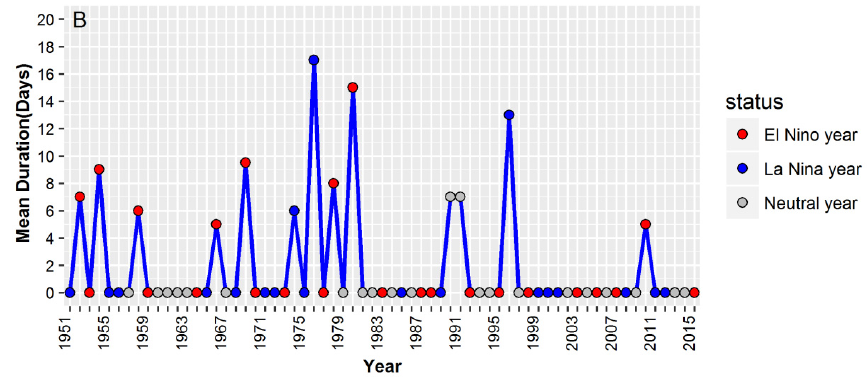
Figure 6. Time series of ( A ) frequency ( B ) mean duration (days) of Cold Spells in Guangzhou during 1951–2015. The solid dots in different colors show the occurrence of El Niño years, La Niña years and Neutral years. The index of total duration and maximum duration of cold spells was ignored due to only one or two cold spells per year.